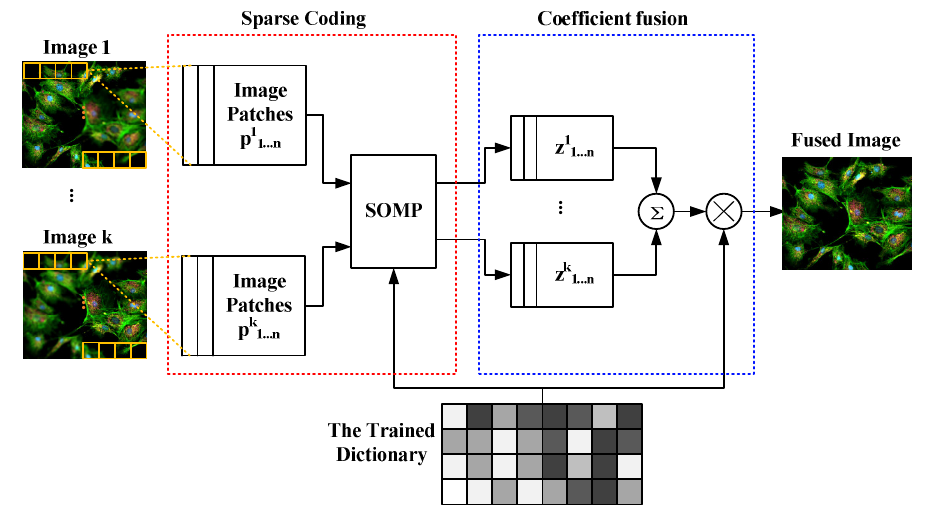
Figure 5. Proposed Image Fusion